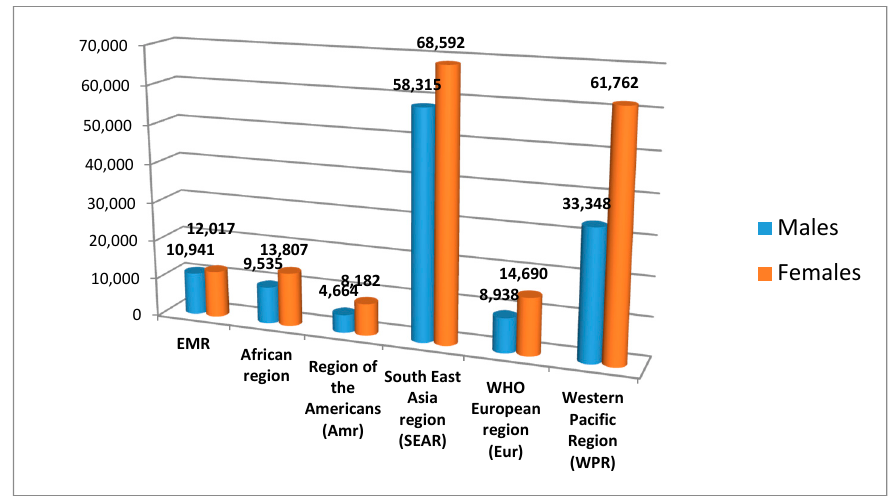
Figure 3. Comparison of the prevalence of Rheumatic heart disease in the Eastern Mediterranean region with other regions in the world in 2015.